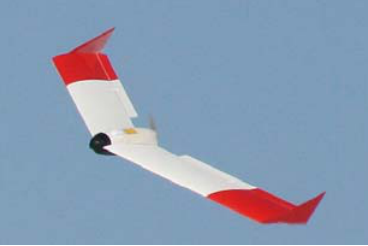
Figure 1: PAMS UAV (Germap,